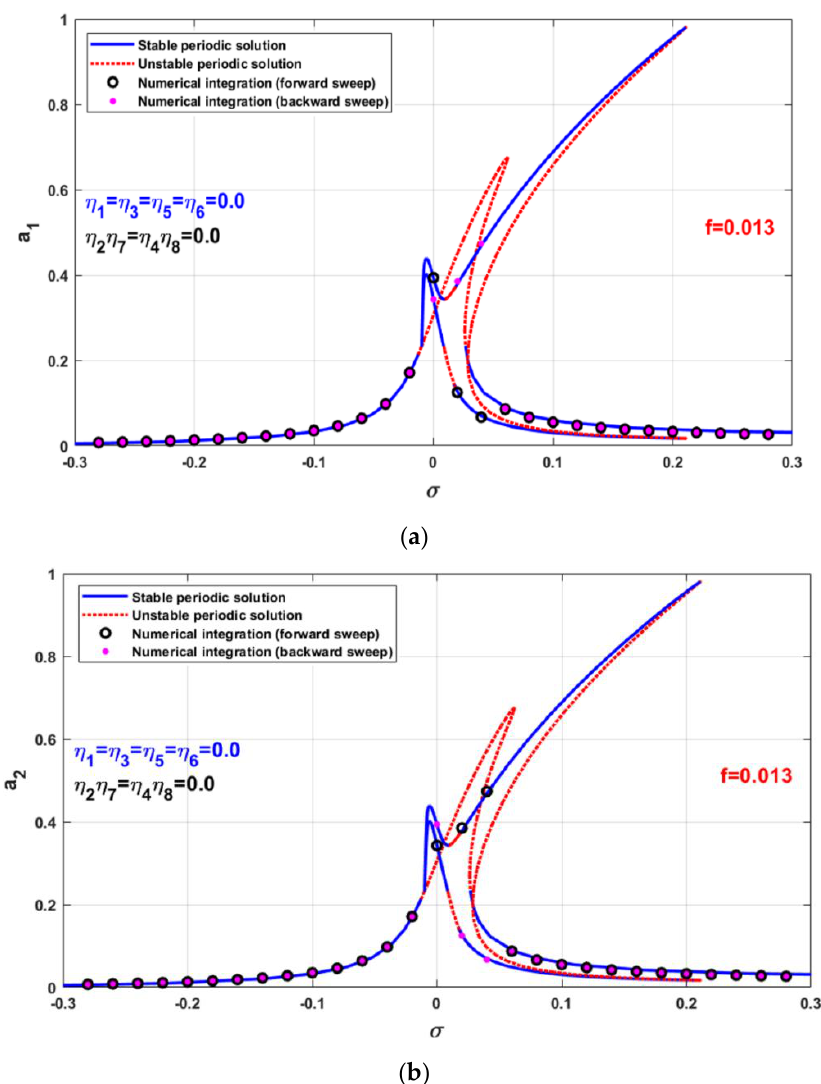
Figure 8. Vibration amplitudes of the rotor system without the LIPPF-controller using 𝜎 as a bifur- cation parameter when 𝑓 = 0.013 : ( a ) vibration amplitude in 𝑋 1 direction and ( b ) vibration ampli- tude in 𝑋 2 direction.